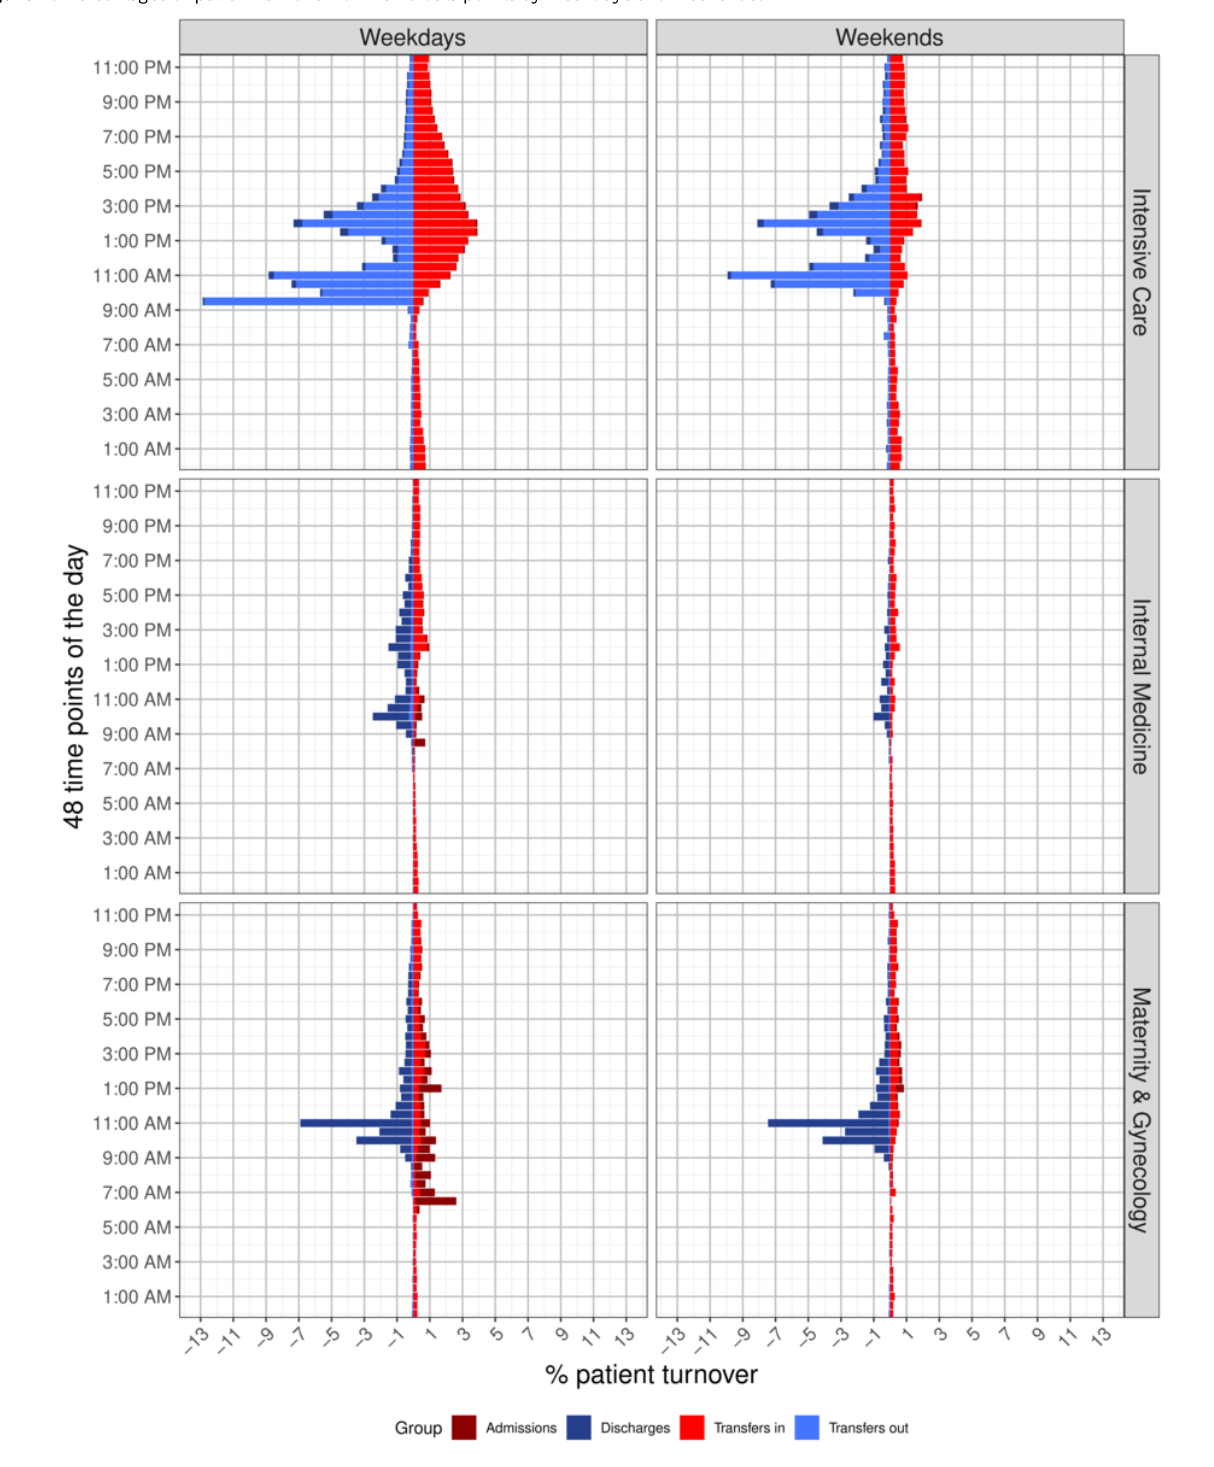
Figure 4. Percentages of patient turnover for the 48 data points by weekdays and